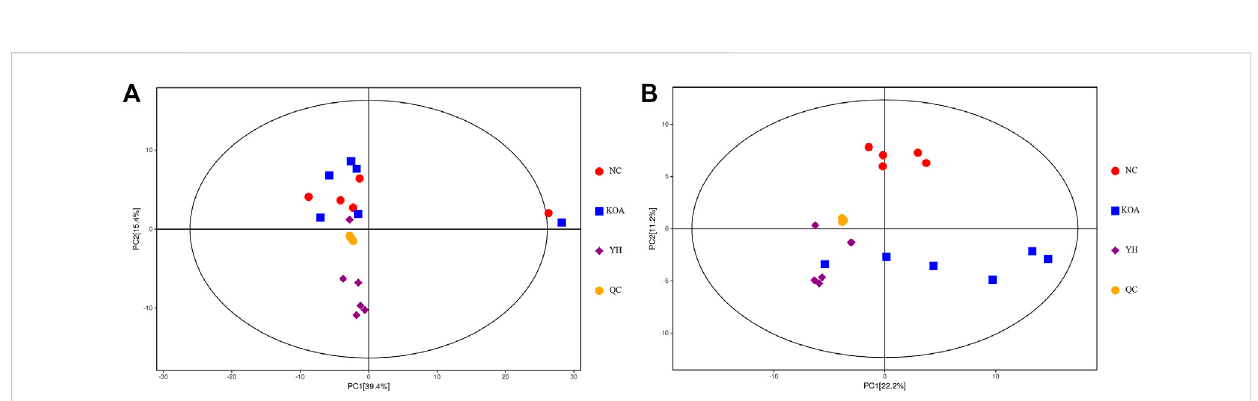
PCA score plotsof theQC, NC, KOA, and YH groups. (A) Positiveion modes. (B) Negative ion modes.NC group (n = 5), KOA group (n = 6), YHgroup (n =